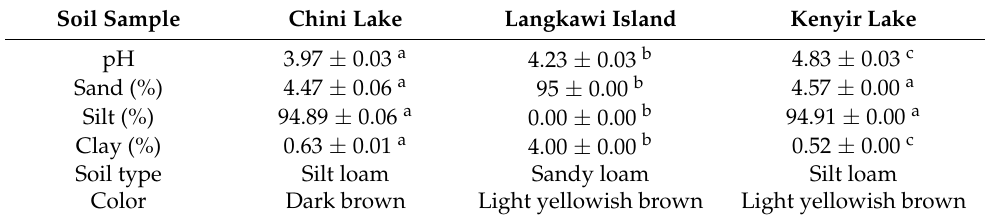
Table 1. Physical properties of soils.